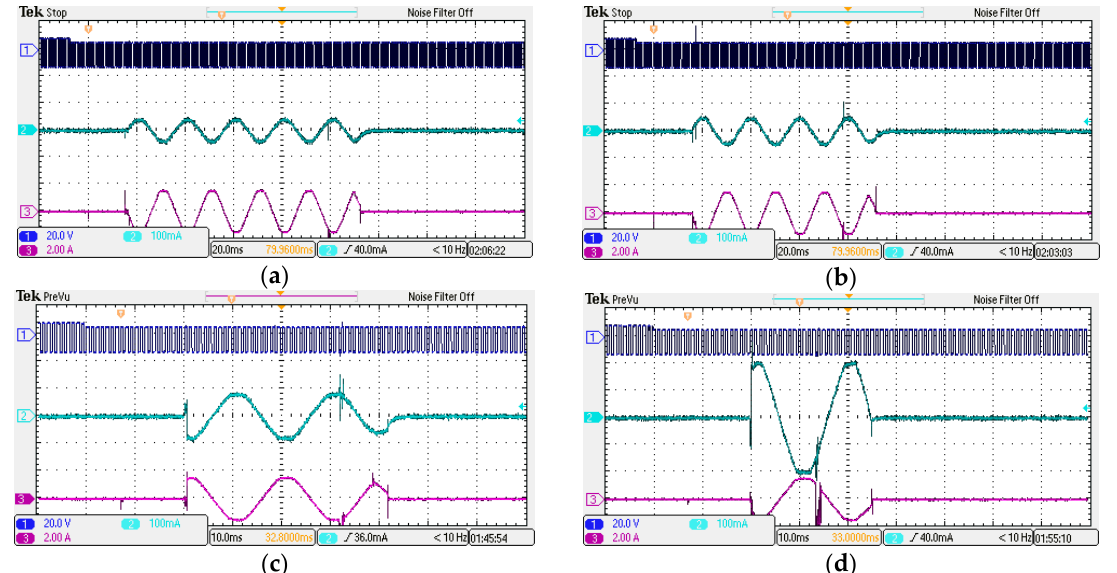
Figure 5. Residual current device (RCD) experimental tests; Ch 1 – u CP, Ch 2 – i RCD, Ch 3 – i L 1 : ( a ) i RCD = 30 mA; ( b ) i = 35 mA; ( c ) i = 60 mA; ( d ) i = 150 RCD RCD RCD